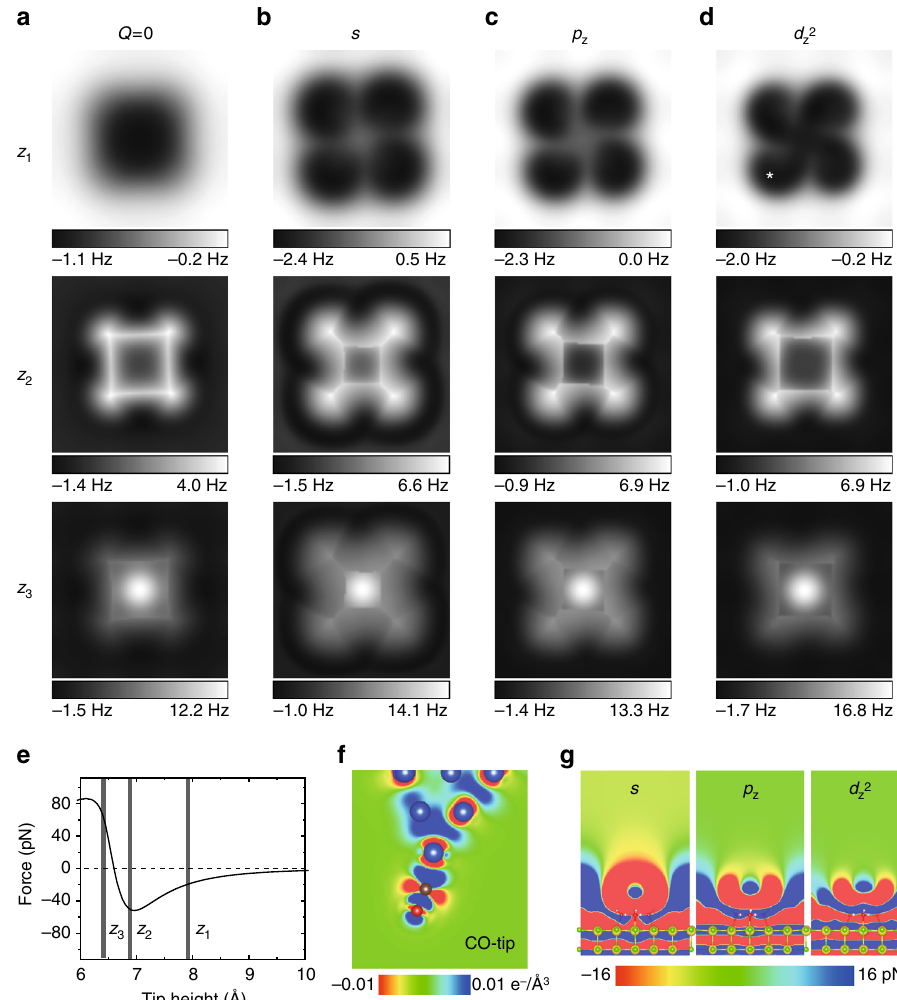
Fig. 2 The role of electrostatics in the high-resolution AFM imaging of a water tetramer. a – d Simulated AFM images of a water tetramer with neutral, s , p z and d z 2 tip models, respectively ( k = 0.5 N m − 1 , Q = − 0.2 e). The fi rst, second, and third rows correspond to the images acquired at the tip heights of about z = 7.9 Å, z = 6.8 Å and z = 6.4 Å, respectively. For a better comparison, we had chosen similar simulation images by subtracting a small offset of tip 1 2 3 height between different tips. The tip height is de fi ned as the distance between the outmost metal atom of the tip and the upward H atom of the water tetramer. The oscillation amplitude of all the simulated Δ f images is 100 pm. The size of the images is 1.2 nm × 1.2 nm. e Simulated force curve of the water tetramer taken with the d z 2 tip, where the three tip heights ( z 1 , z 2 , and z 3 ) are denoted. The tip position is indicated by a star in d . f Charge distribution of the CO-tip from DFT calculations. g Maps of calculated vertical electrostatic forces between the sample and different tip models ( s , p z and d z 2 ) computed by convolution of Hartree potential of sample and model charge distribution on the tip